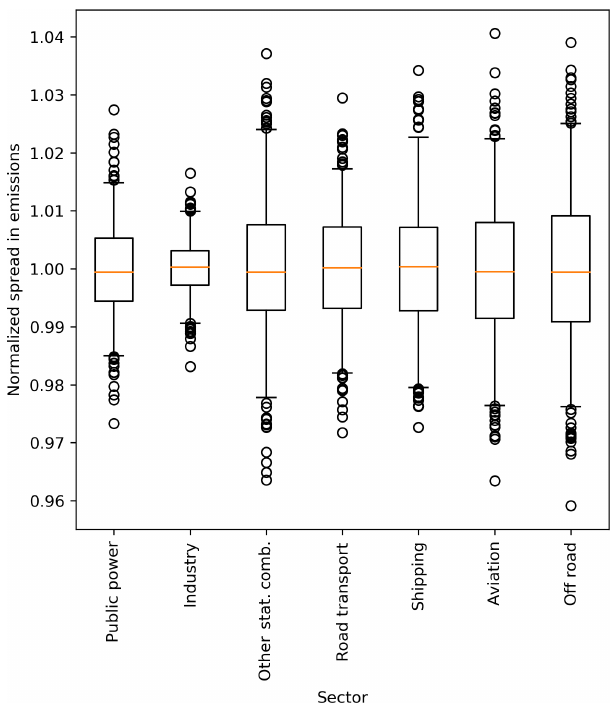
Figure 13. Normalized spread in emissions of CO 2 and CO per sector due to uncertainties in temporal profiles. The box represents the interquartile range, the whiskers the 2.5–97.5 percentiles, the lines the median values, and the circles are outliers. The spread is the same for CO 2 and CO, because they have the same temporal profiles.